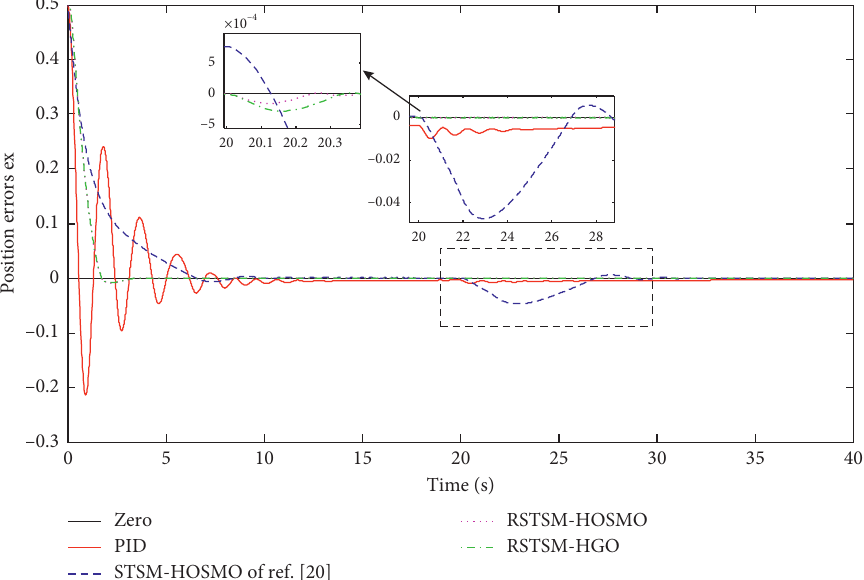
Figure 12: Trajectory tracking error with